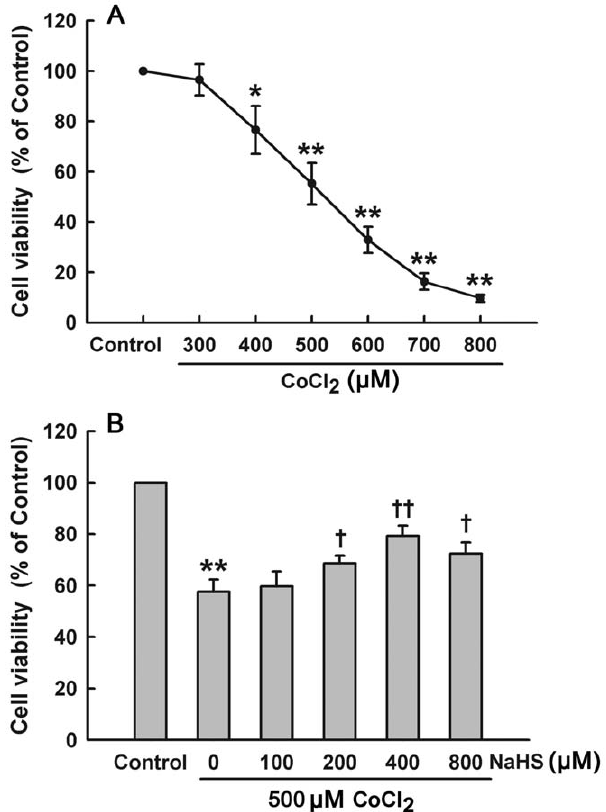
Figure 1. H 2 S protects HaCaT cells against CoCl 2 -elicited cytotoxicity. ( A ) HaCaT cells were treated with CoCl 2 at